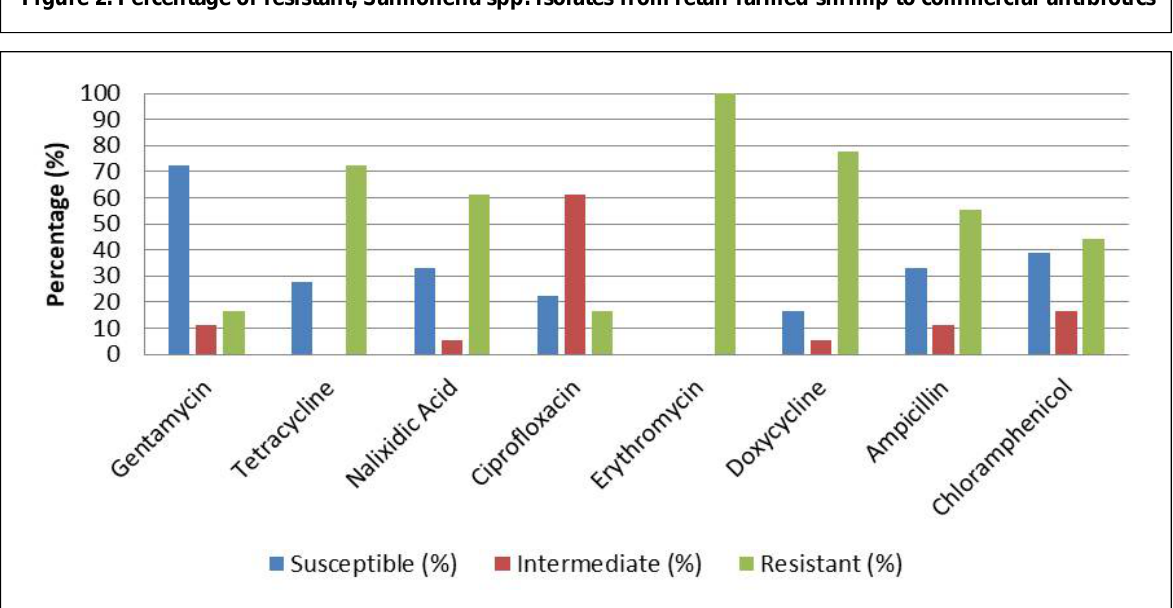
Figure 2: Percentage of resistant, Salmonella spp. isolates from retail farmed shrimp to commercial antibiotics